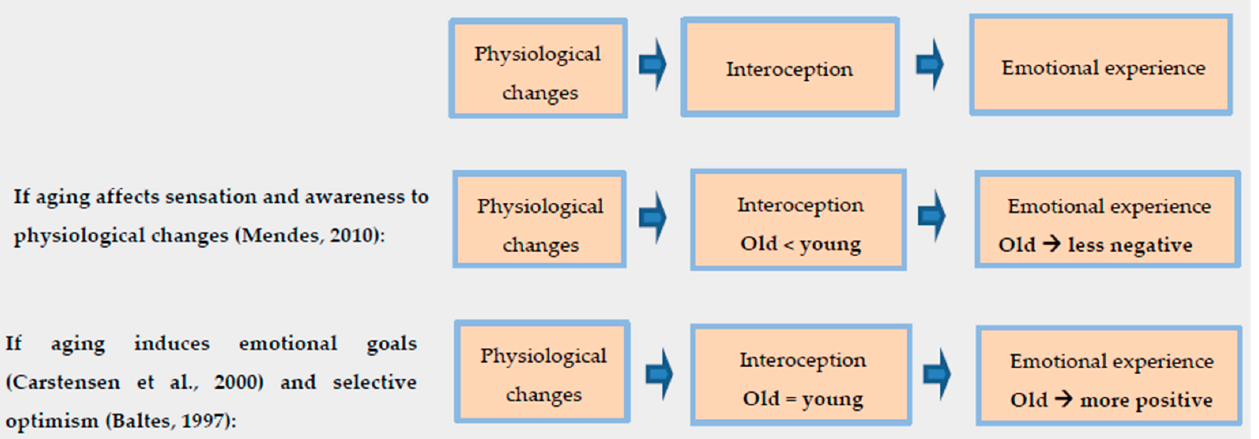
Figure 1. The role of interoception with different predictions following relevant theories